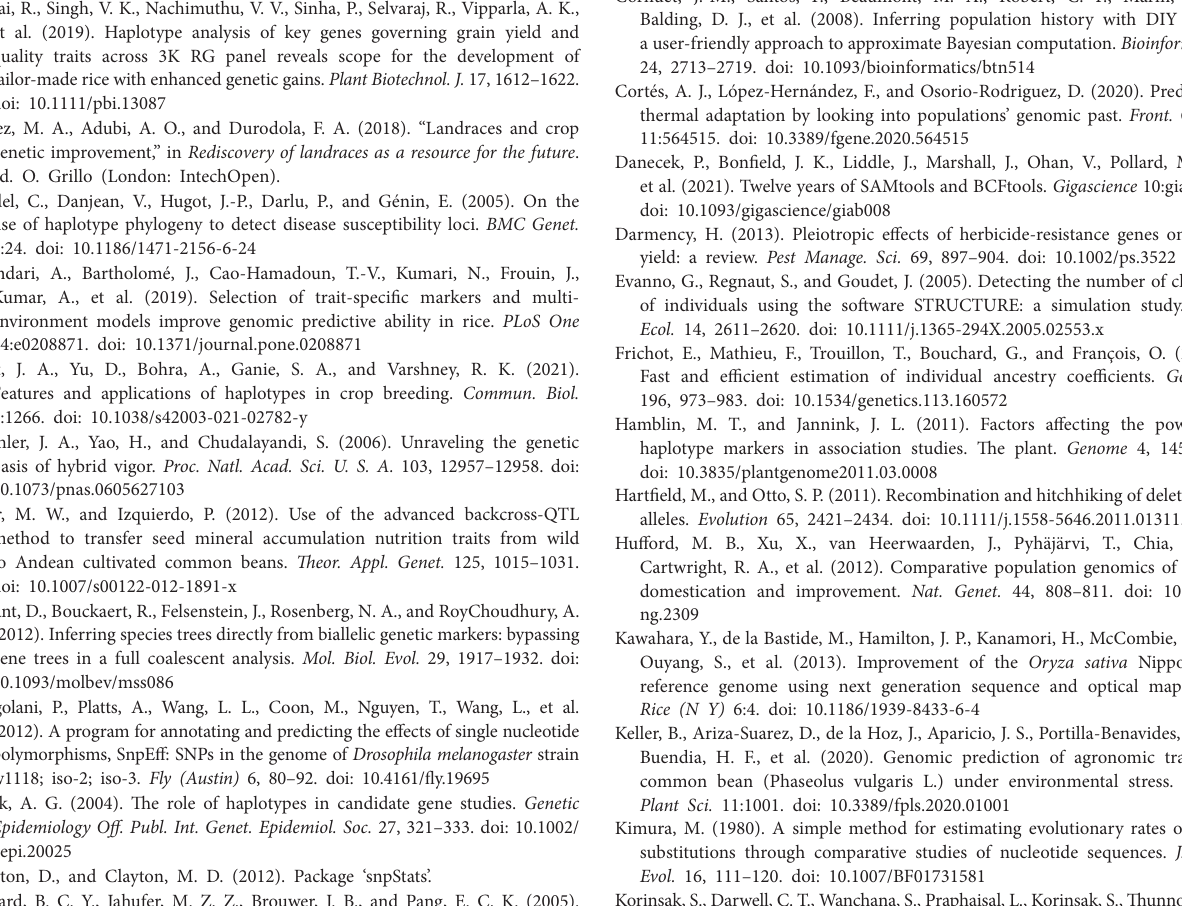
Supplementary Table S4 | GO Slim information for annotated genes identified across NFV accessions (generated at: http://rice.uga.edu/downloads_gad.shtml; accessed 16/09/21). See Supplementary Table S4 .